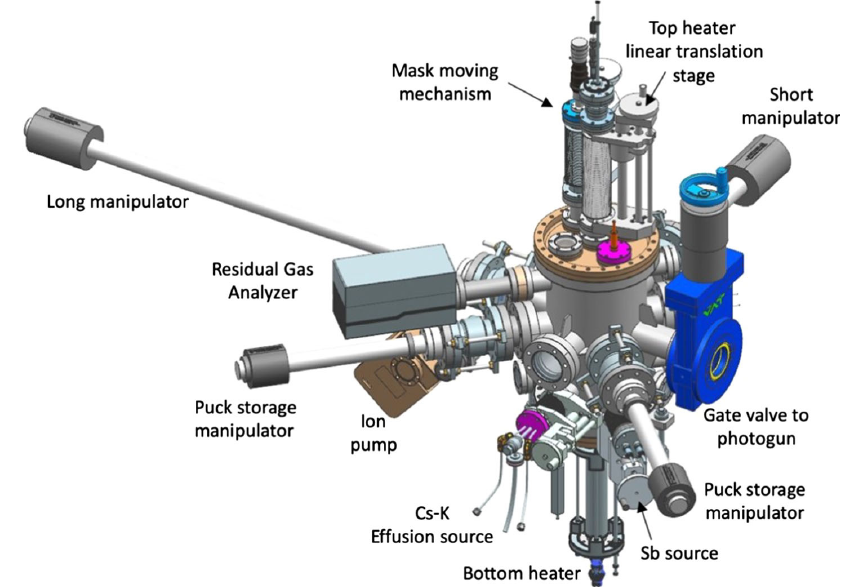
FIG. 1. Photocathode deposition